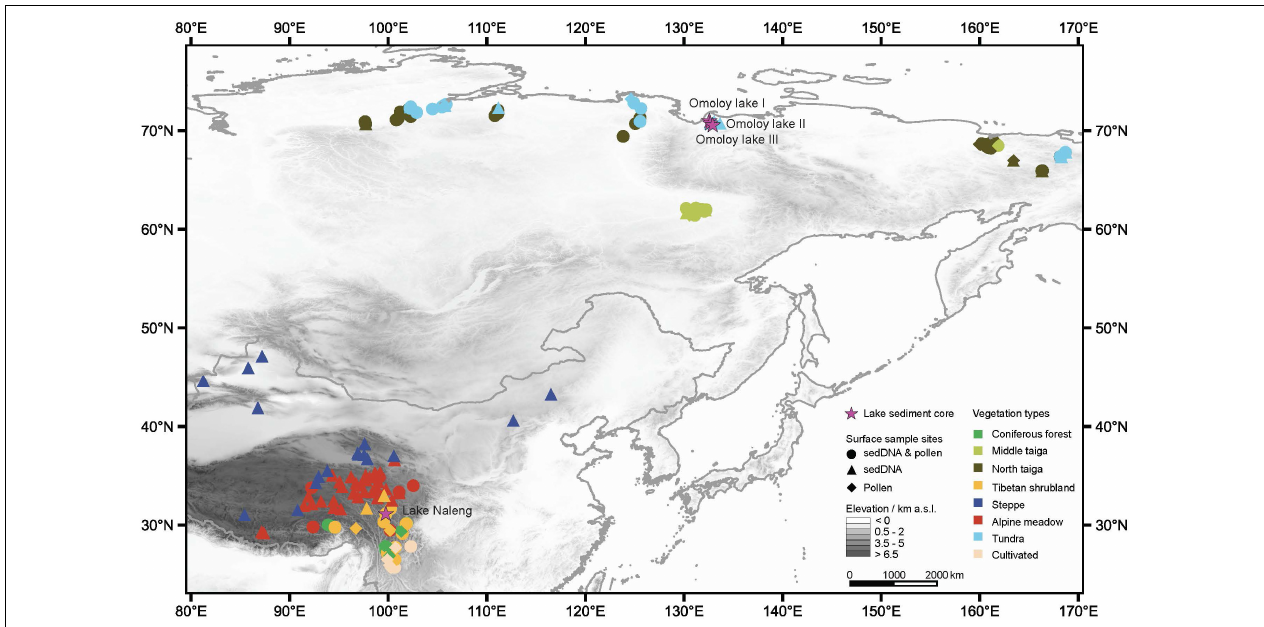
FIGURE 1 | Distribution of the lake sediment cores and the modern surface samples with their corresponding vegetation type. Four sediment cores (purple stars) were taken: Lake Naleng (glacial lake, treeline ecotone, back-to 17.7 ka), Omoloy lake I (thermokarst lake, typical tundra, back-to 5.6 ka), Omoloy lake II (thermokarst lake, forest-tundra, back-to 7.6 ka), and Omoloy lake III (thermokarst lake, open larch forest, back-to 4.8 ka). A total of 190 modern sedimentary DNA (sedDNA) samples and 136 modern pollen samples were used for modern analogue matching, where 113 sites were analysed for both proxies (circles), with a further 77 sites analysed for sedDNA (triangles) and another 23 sites for modern pollen data (diamonds). Each of the eight modern training-sets contain eight vegetation types. This map was generated by QGIS software (version 3.14). The digital elevation data was download via https://www.earthenv.org/topography (Amatulli et al.,